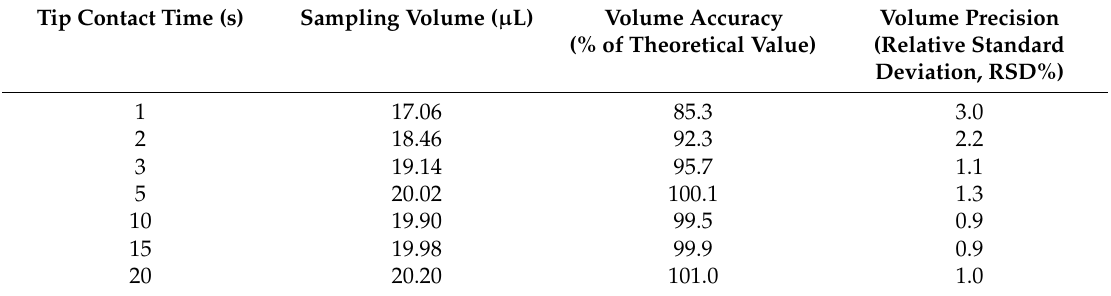
Table 1. Plasma volumetric absorptive microsampling (VAMS) volume accuracy and precision results. Tip Contact Time